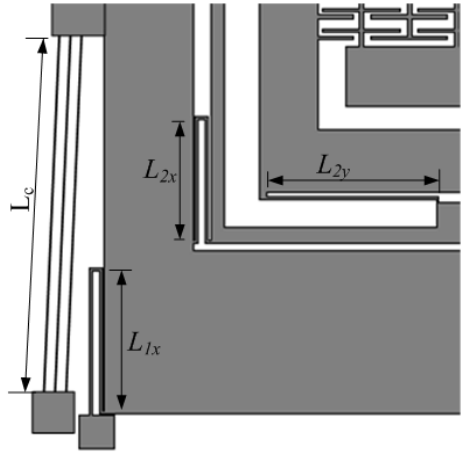
Figure 6. Suspension system configuration that forms the 2-DoF drive and 1-DoF sense mode